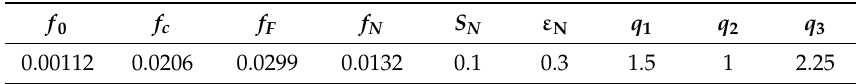
Table 8. The parameters of 5052-O aluminum alloy in the Gurson-Tvergaard-Needleman (GTN) damage